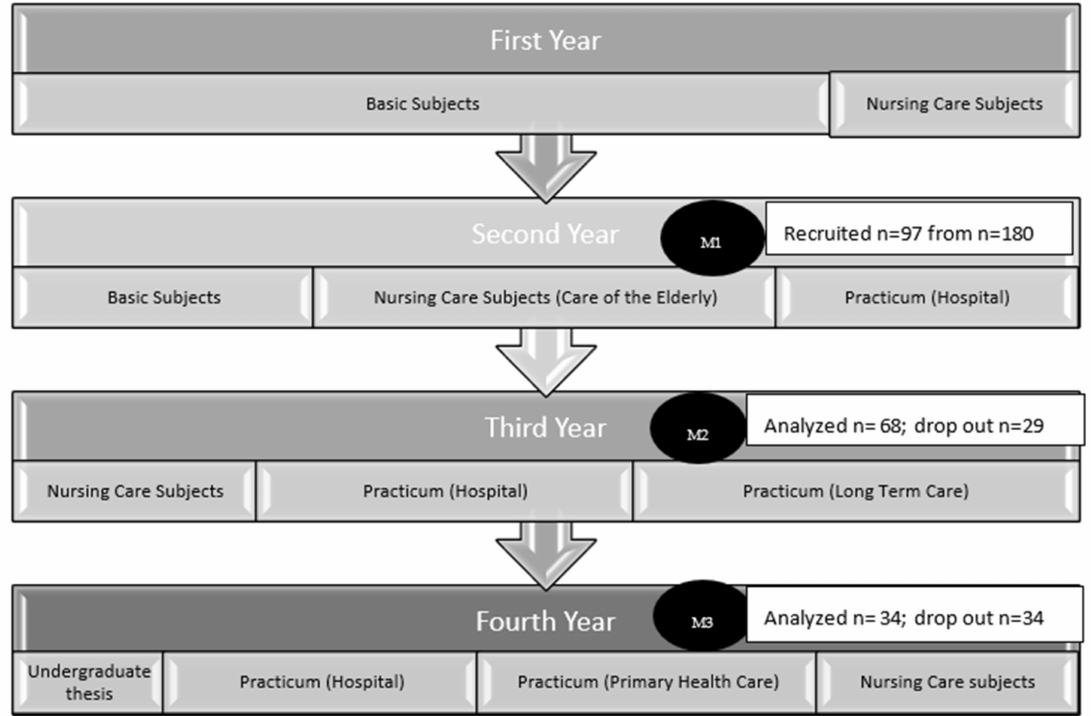
Figure 1. Flow chart of the study and curriculum of the nursing degree